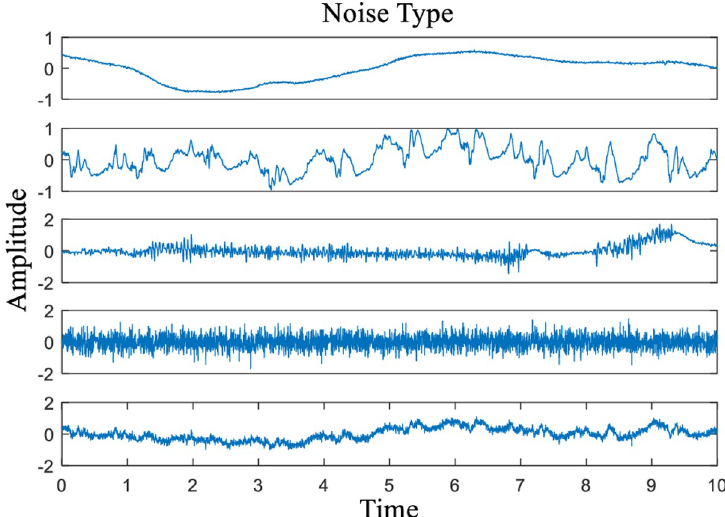
Fig 6. Five categories of noise used in the experiments (from top to bottom, the noise types are BW, ECN, EMG, WN and HN). https://doi.org/10.1371/journal.pone.0235330.g006 Table 4 , the SNR improvement results of the real ECG signals are also very good but not as good as those of the synthetic ECG signals. This is because the original real ECG signals are from the MITDB and contain some small noise, including baseline wandering, which is also eliminated effectively in the denoising process. As a result, if the original real ECG signal is used as the clean signal to calculate the SNR, it will reduce the SNR improvement. However, in fact, the denoised ECG in our method is closer to a clean ECG compared with the original real ECG. This is illustrated in Fig 8 . The red lines represent the original real ECG. The blue line represents the ECG with BW, and the black line represents the denoised ECG by IEMD-ATD.